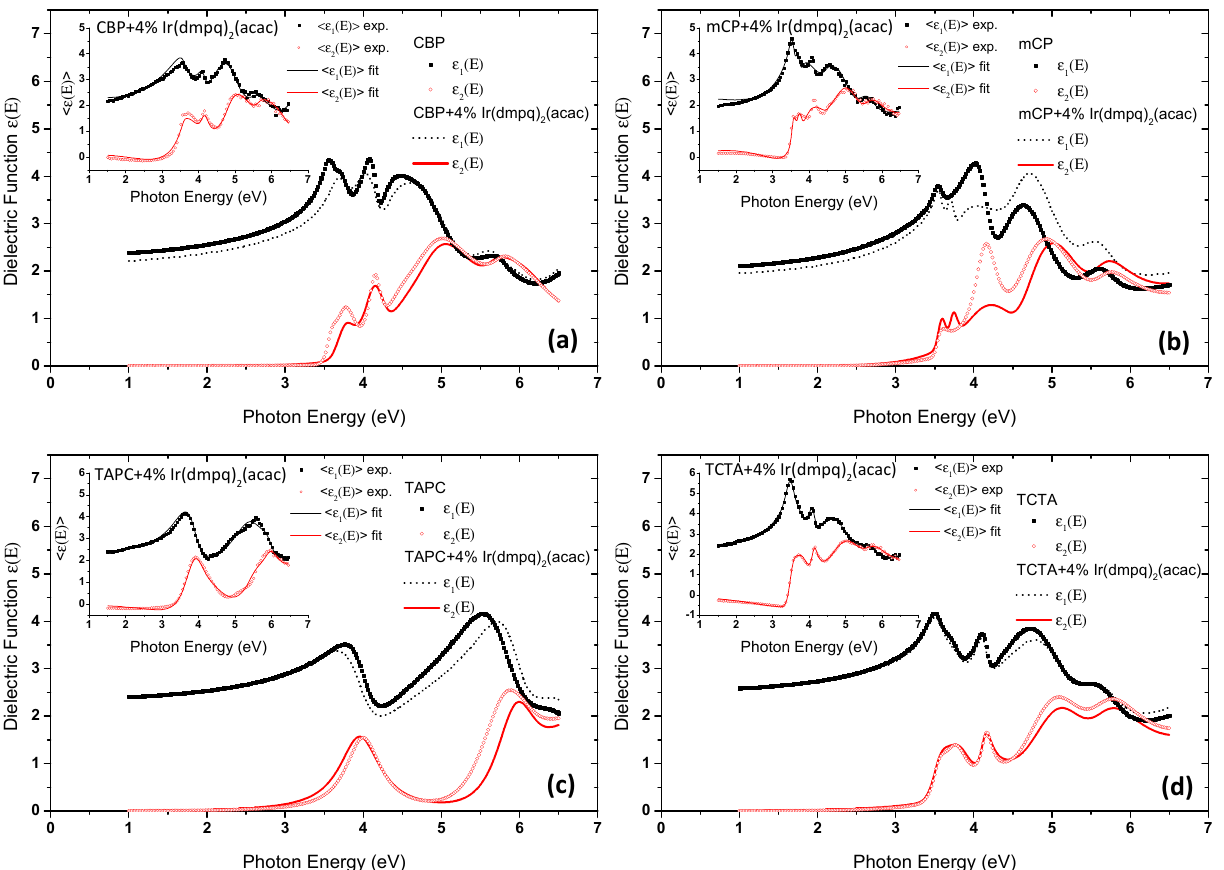
Figure 1. The bulk ε (E) as they were calculated by the SE analysis of the undoped (symbols) and doped (lines) organic films: ( a ) CBP; ( b ) mCP, ( c )TAPC; ( d ) TCTA. Insets show the experimental (symbols) < ε (E)> and the corresponding fitted ones (lines) of the studied doped organic films.